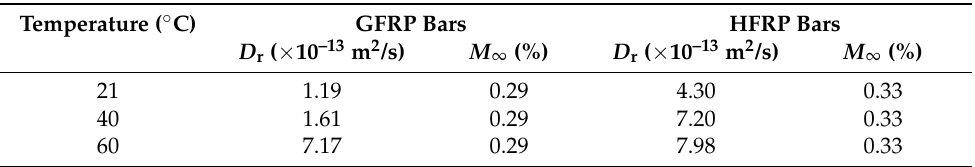
Figure 5. The saturation water absorption of ( A ) the GFRP bars and ( B ) the HFRP bars. Table 1. The diffusion coefficient and saturation water absorption of the FRP bars fitted by the Equation